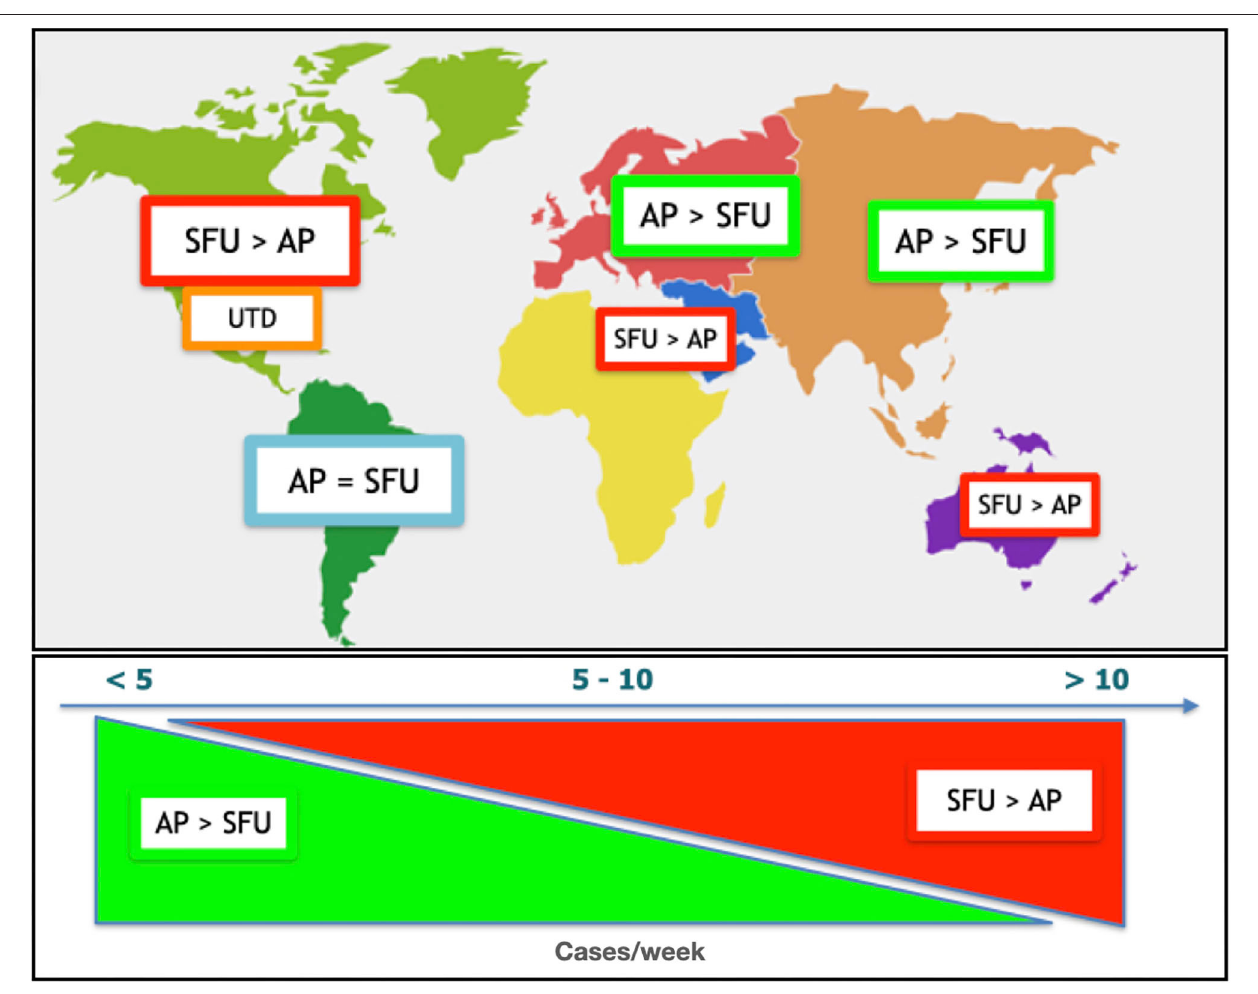
FIGURE 3 | Difference of preferences based on geographical provenience (Top) and cases per week volume (Bottom)